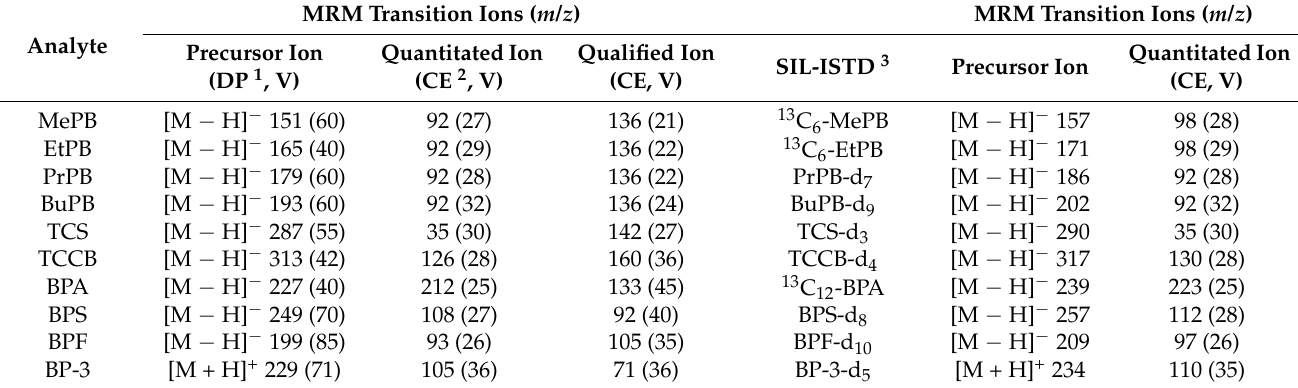
Table 1. MS/MS parameters for parabens, bisphenols, triclosan and benzophenone and correspond- ing SIL-ISTDs 3